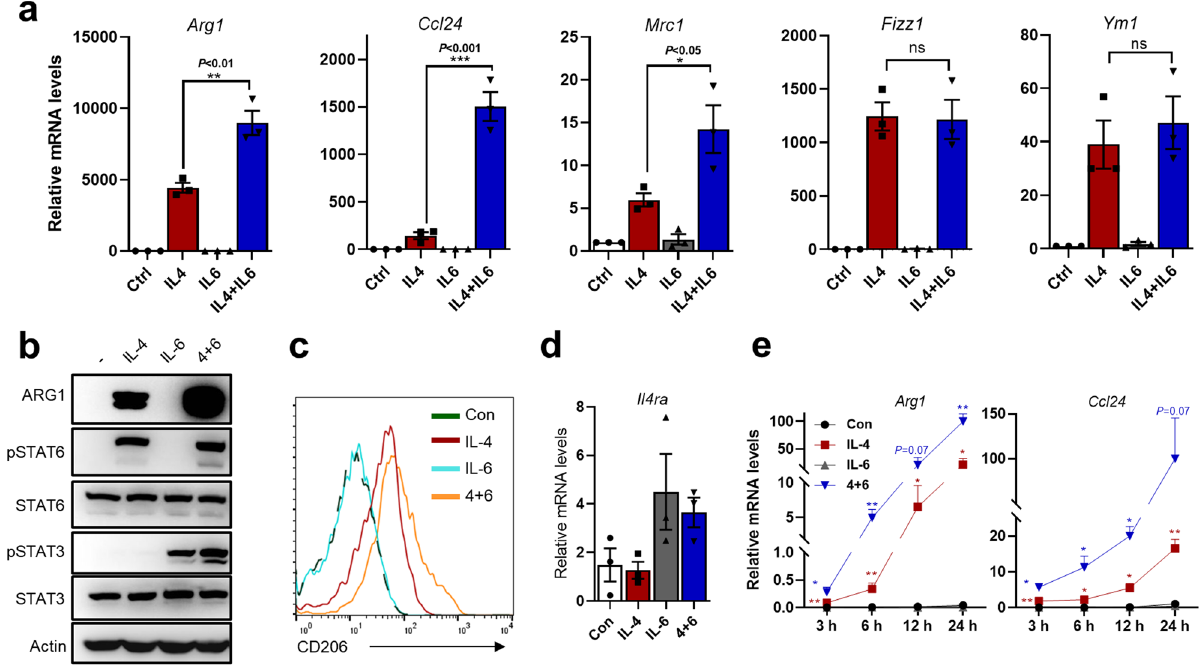
Figure 2. IL-6 signaling can tightly coordinate with IL-4 signaling, leading to enhancement of a group of prominent M2 markers in macrophages. ( a–d ) BMDMs were stimulated with individual cytokines (10 ng/ml of IL-4 or 40 ng/ml of IL-6) or their combination for 24 h. Some samples were subjected to qPCR (n = 3, ± SEM) ( a,d ) and WB analyses ( b ). For some other samples, the levels of intracellular CD206 in BMDMs were analyzed by flow cytometry ( c ). ( e ) Time course expression levels of Arg1 and Ccl24 in BMDMs treated with ± IL-4 ± IL-6 were analyzed by qPCR (n = 3, ± SEM). Unpaired t tests were performed for individual markers in ( a ), with P values marked on the graphs. For time series of IL-4/IL-6 treatments in ( e ), multiple unpaired t tests (using Holm–Šídák method) were performed to compare the IL-4 group with control group [red asterisks], and the co-treatment group with IL-4 group [blue asterisks], respectively. Asterisks in this figure correspond to P values (*** P < 0.001; ** P < 0.01; * P < 0.05; ns not